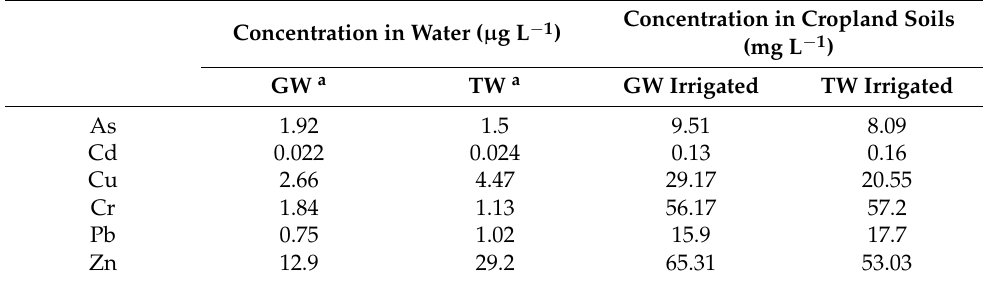
Table 6. The concentration of some HM in GW and TW, and cropland soils irrigated with GW and TW, respectively a [136].